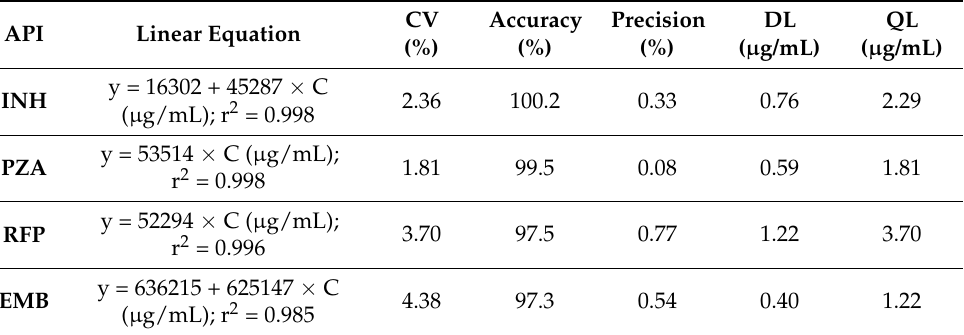
Table 3. Results of the method validation. API: active pharmaceutical ingredient, EMB: ethambutol, INH: isoniazid, PZA: pyrazinamide, RFP: rifampicin, CV: coefficient of variation for the